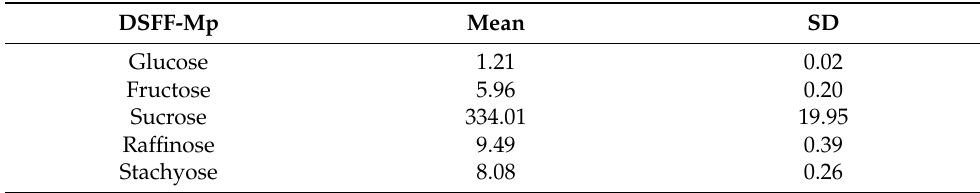
Table 4. DSFF-Mp total sugar content.